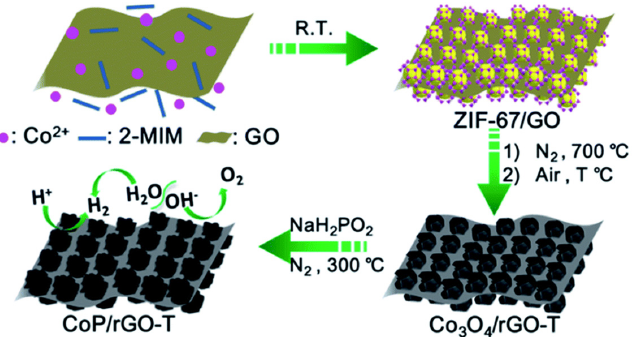
Figure 7. Description of the fabrication process of CoP/rGO ‐ T nanocomposites. Reprinted with permission from Ref. [147]. Copyright 2016 The Royal Society of Chemistry.